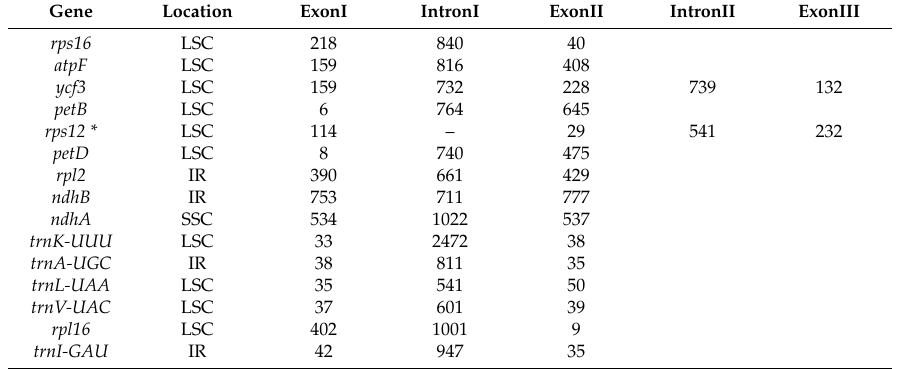
Table 3. The genes having introns in the broomcorn cp genome, and the length of the exons and introns. The length units for the exons and introns are base pair